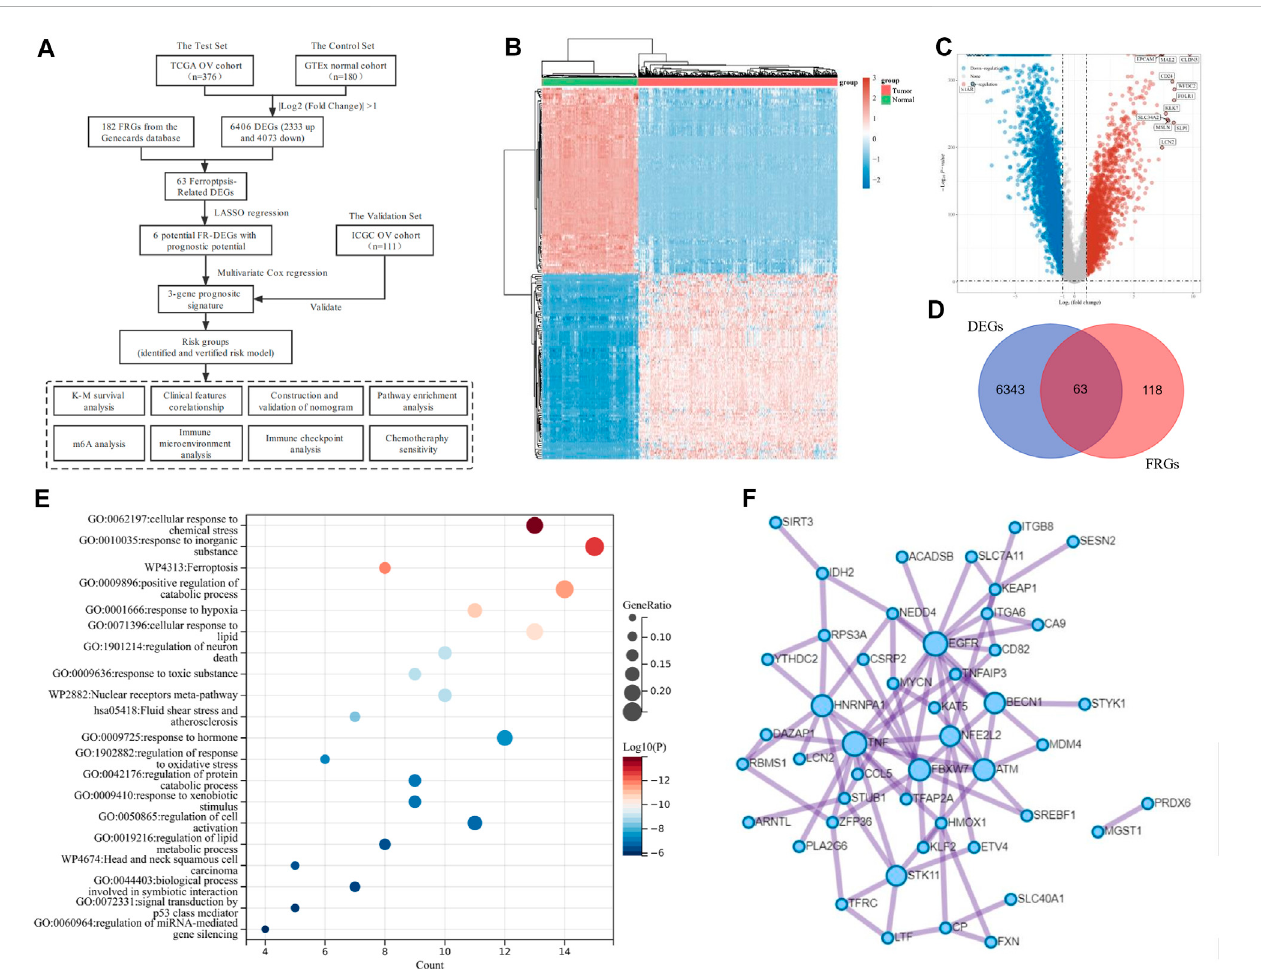
FIGURE 1 Identi fi cationofFerroptosis-RelatedDifferentiallyExpressedgenes(DEGs)inovariancancer(OV). (A) Theoverall fl owchartofthestudy. (B) Theheatmap for differential gene expression. Different colors represent the trend of gene expression between OV and normal tissues. The top 50 downregulated and top 50 upregulated genes were shown. (C) The volcano plot was constructed to list the DEGs between OV and normal tissues via the fold change values and P-adjust. The downregulated and upregulated DEGs were highlighted in blue and red, respectively. (D) The Venn diagram of the differentially expressed ferroptosis-related genes (DE-FRGs). (E) Overview of the Kyoto Encyclopedia of Genes and Genomes (KEGG) and Gene Ontology (GO) pathway enrichment analysis ofprimarybiologicalactionsforthe63DE-FRGs. Here,thetop20clusterswerelisted. Thecolorscale represented p -value,andthesizeofthecircles represented the gene ratio. (F) The protein-protein interaction (PPI) network of the